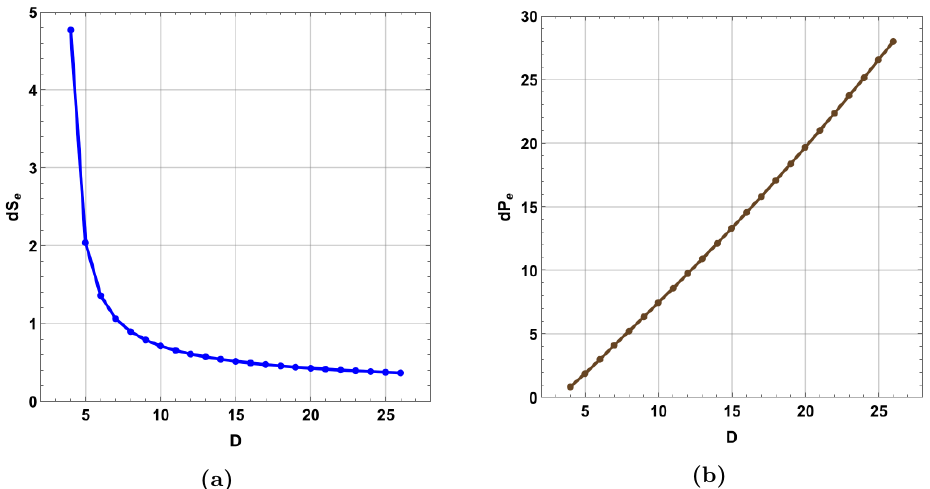
Figure 5. Entropy (a) and pressure (b) variation dP as a function of spacetime dimension with | p r | = 1 , Q = 1 , l = 1 and dQ = 0 . 1 . h